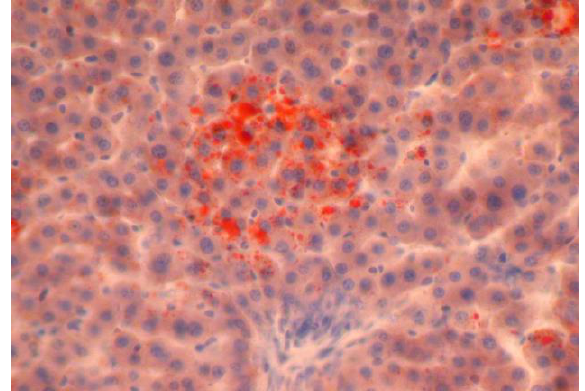
Fig. 6. Rat liver, which on the background of ethyl alco- hol was injected with a fiber of plum fruit. Fatty drops in the cytoplasm of cells were small or pinnate. Frozen tissue slices, Sudan ΙV. ×250